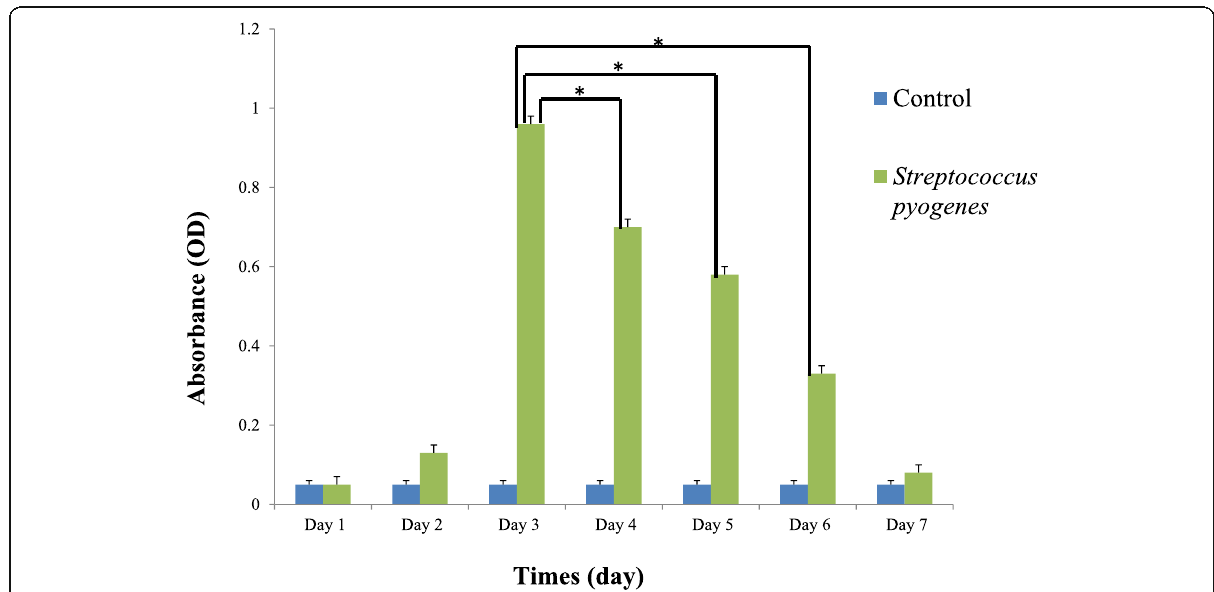
Fig. 3 Biofilm formation by Streptococcus pyogenes. Quantitative biofilm analysis for 7 days in microtiter plate. Asterisk* indicates the mean differences were significant ( p ≤